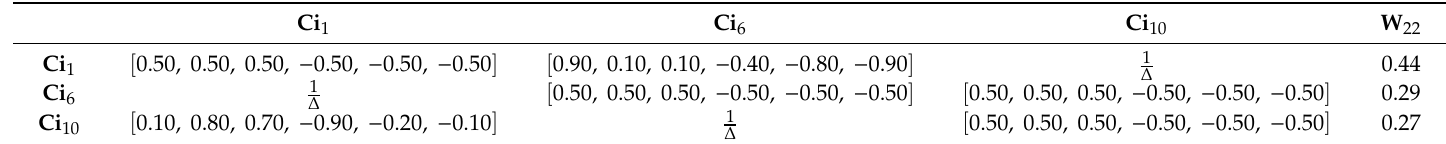
Table 7. Interior interdependencies matrix of factor C 2